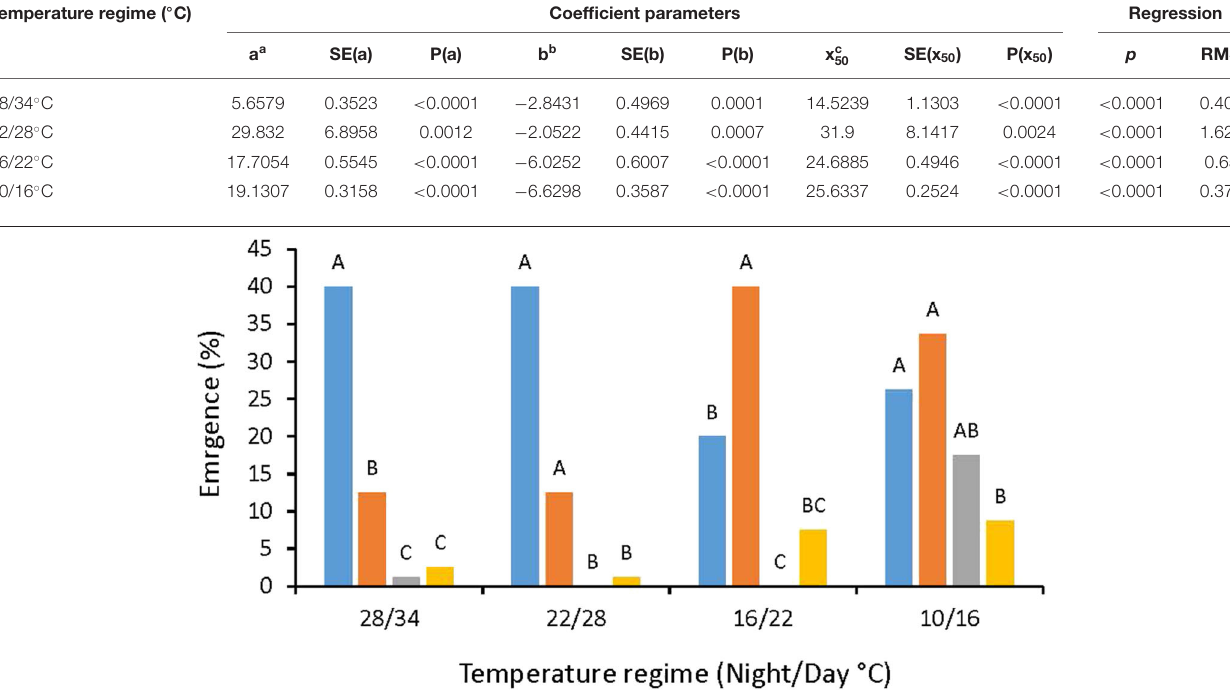
TABLE 2 | Three-parameter logistic nonlinear regressions between A. confertiflora emergence and time (days). Temperature regime ( ◦ C)